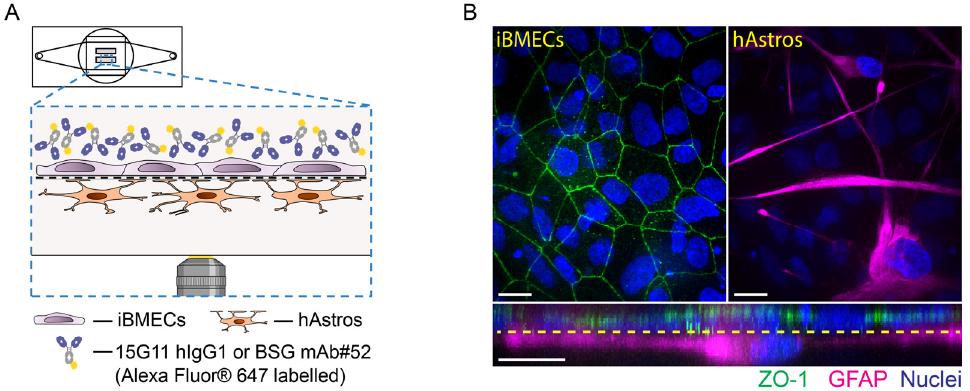
Figure 4. The µSiM-iBMEC contact co-culture model. ( A ) Schematic illustration of the µSiM-iBMEC contact co-culture model during the transcytosis experiment. ( B ) Immunocytochemical analysis of the µSiM-iBMEC co-culture model. Green: ZO-1 (iBMECs), magenta: GFAP (hAstros), blue: nuclei (both cell types); scale bars represent 20 µm.